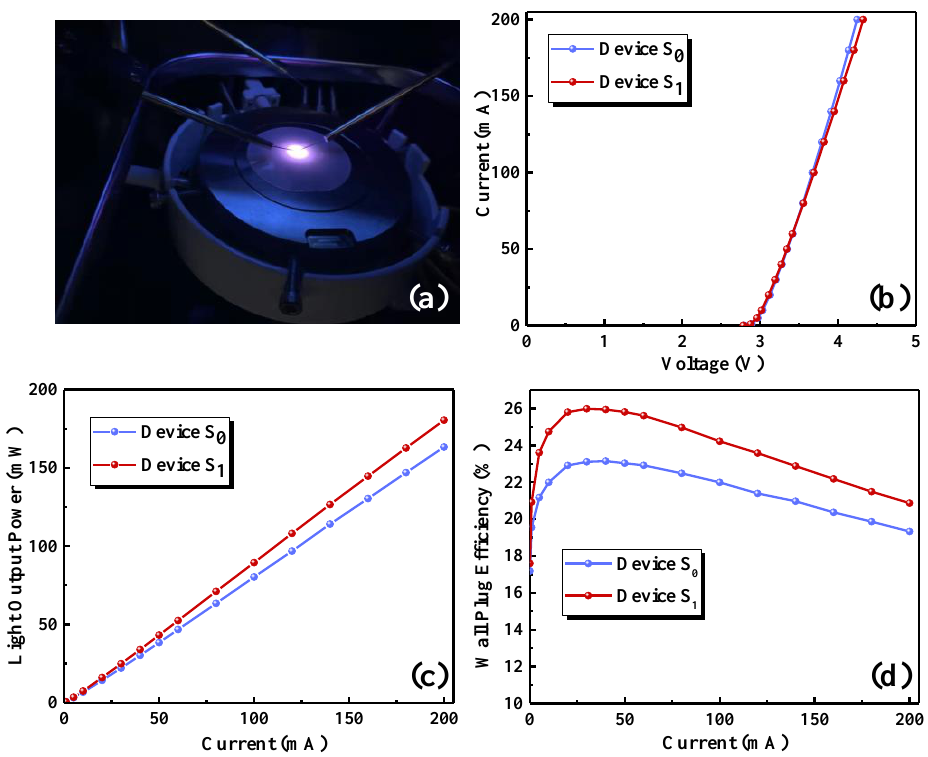
Figure 4. ( a ) the electroluminescence image of the Device S 1 ; ( b ) I-V characteristic ( c ) the light output power and ( d ) WPE curve versus injection current of devices.